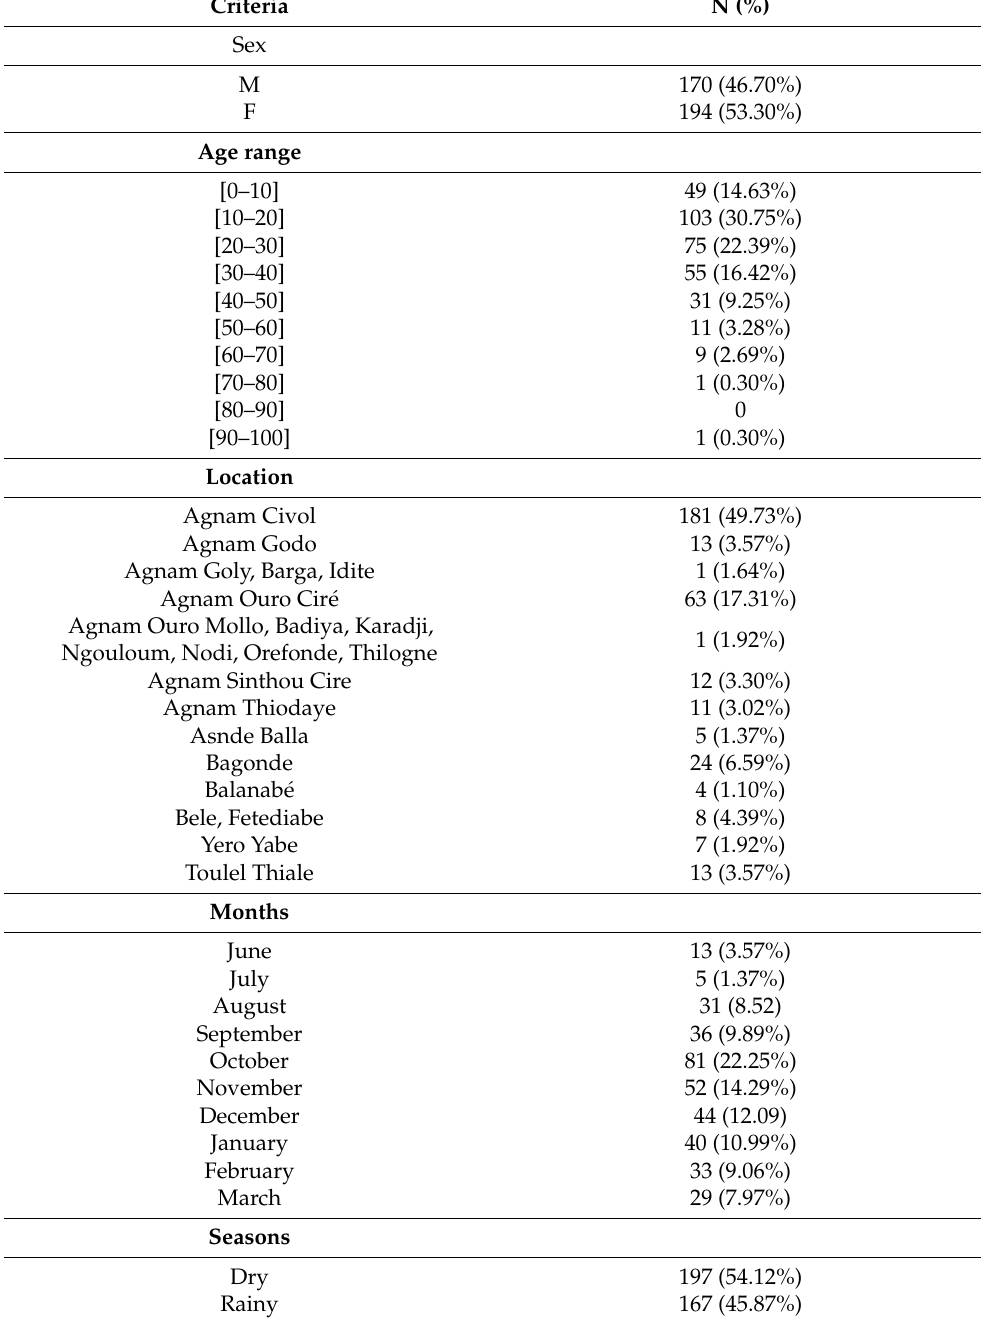
Table 1. Social and demographical presentation of the human